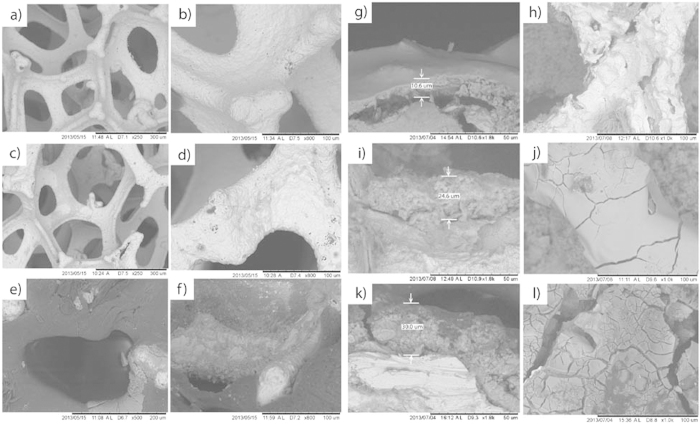
SEM micrographs of:(a,b) PPI, (c,d) PCPI and (e,f) PIPI samples after 1 week of degradation. Degradation layer and surface morphology of (g,h) PPI, (i,j) PCPI and (k,l) PIPI samples after 4 weeks of degradation.